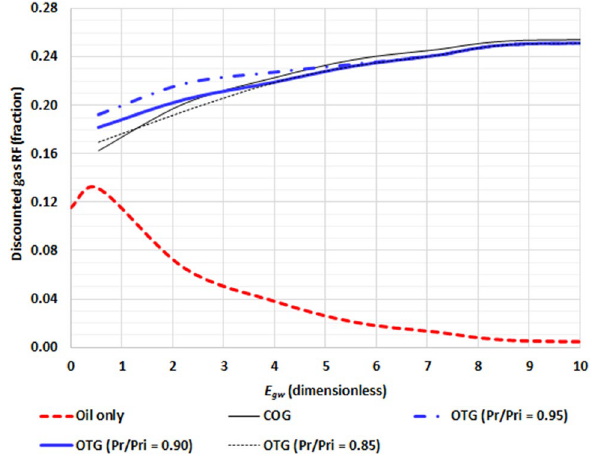
Fig. 7 Discounted AG RF versus E gw (10% discount rate) with hori- zontal oil producers. Note that E gw = 0 refers to the undersaturated cases